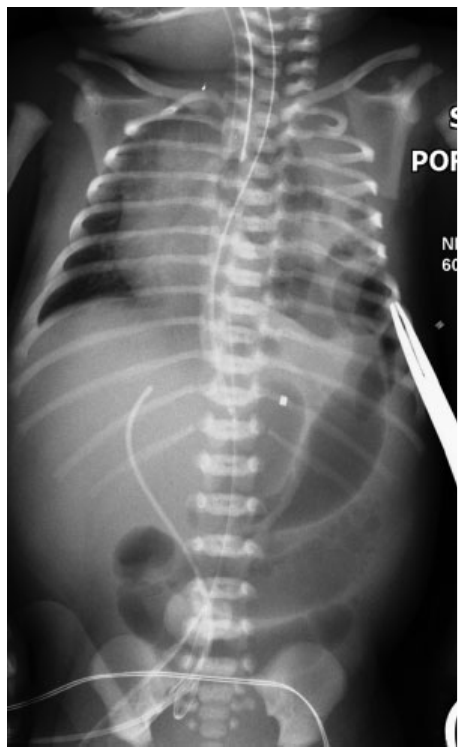
Fig. 2 Chest and abdomen radiograph at 14 hours of age, showing dilated bowel loops with overlying gas bubbles. The square radio-opacity over the 11th rib represents the steel tip at the end of the in utero – inserted